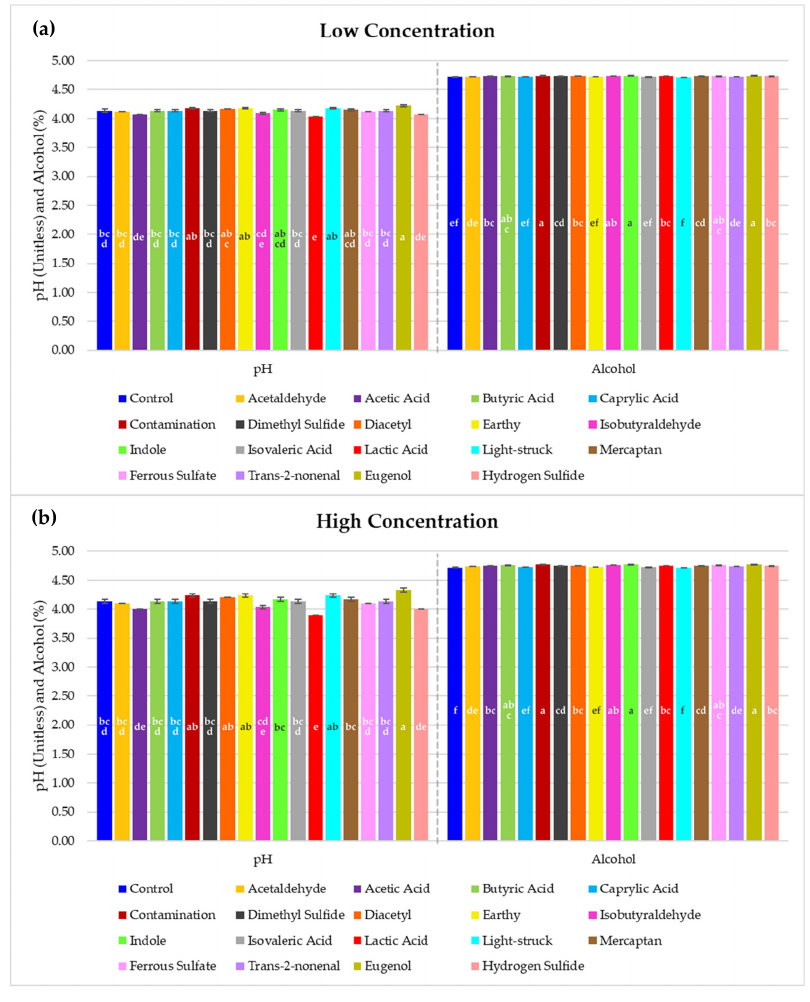
Figure 6. Bar graphs of the pH and alcohol mean values for ( a ) low and ( b ) high concentration treatment. Error bars are based on standard error. Different letters depict significant differences (p < 0.05) between samples for each sensor based on the Tukey honest significant difference (HSD) post-hoc test. Table 3. Statistical results of the artificial neural network classification models developed using the near-infrared absorbance values Model 1 and electronic nose outputs (Model 2) as inputs to predict the concentration level. Abbreviations: MSE: means squared